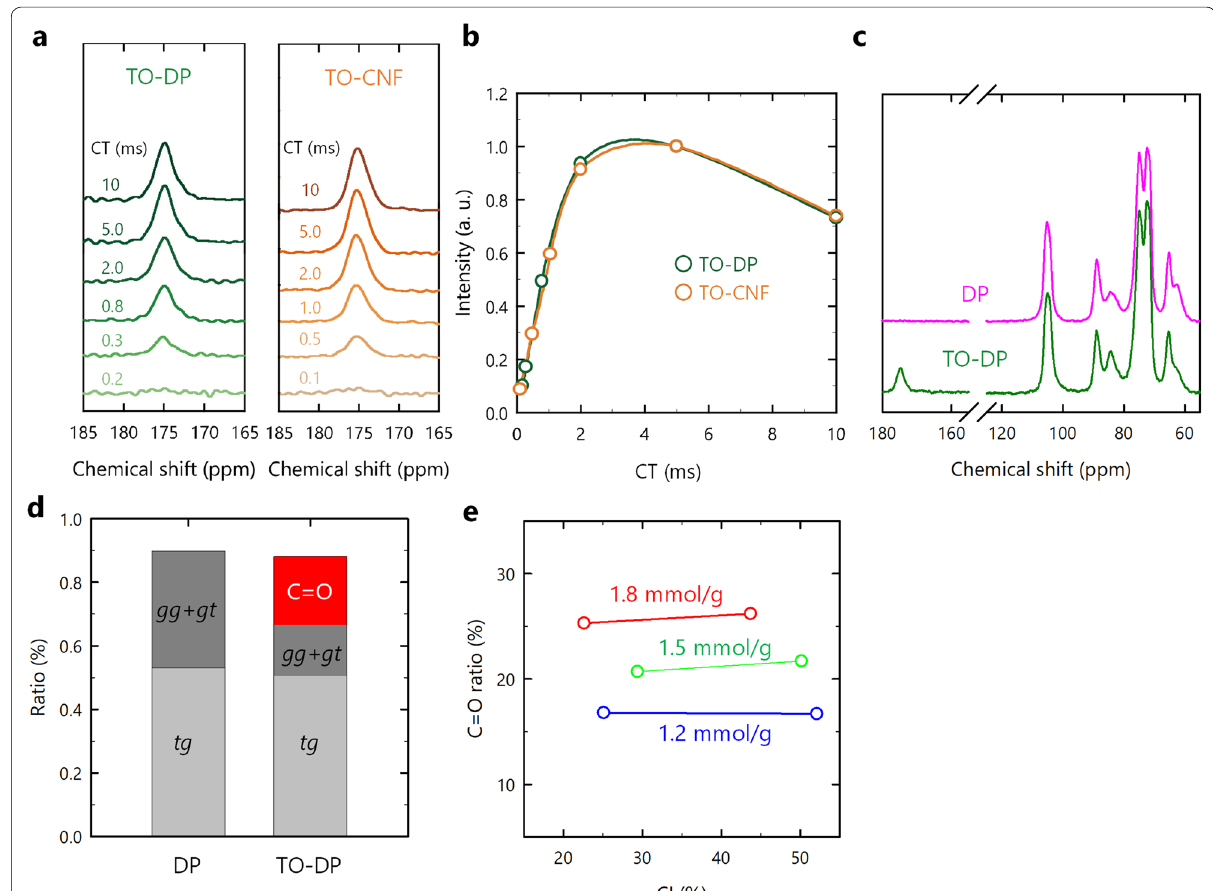
Fig. 3 a Spectral change in the carbonyl region of TO-DP and TO-CNF with CT. b Dependency of CT on the signal intensity corresponding to the carbonyl carbon. c Change in the NMR spectra at 2 ms CT with TEMPO-oxidation. d Change in the signal ratio of the conformation of the C6 hydroxy group and carbonyl carbon. e Relationship between the CI value and the carbonyl ratio calculated as the signal ratio of the carbonyl carbon to the C1